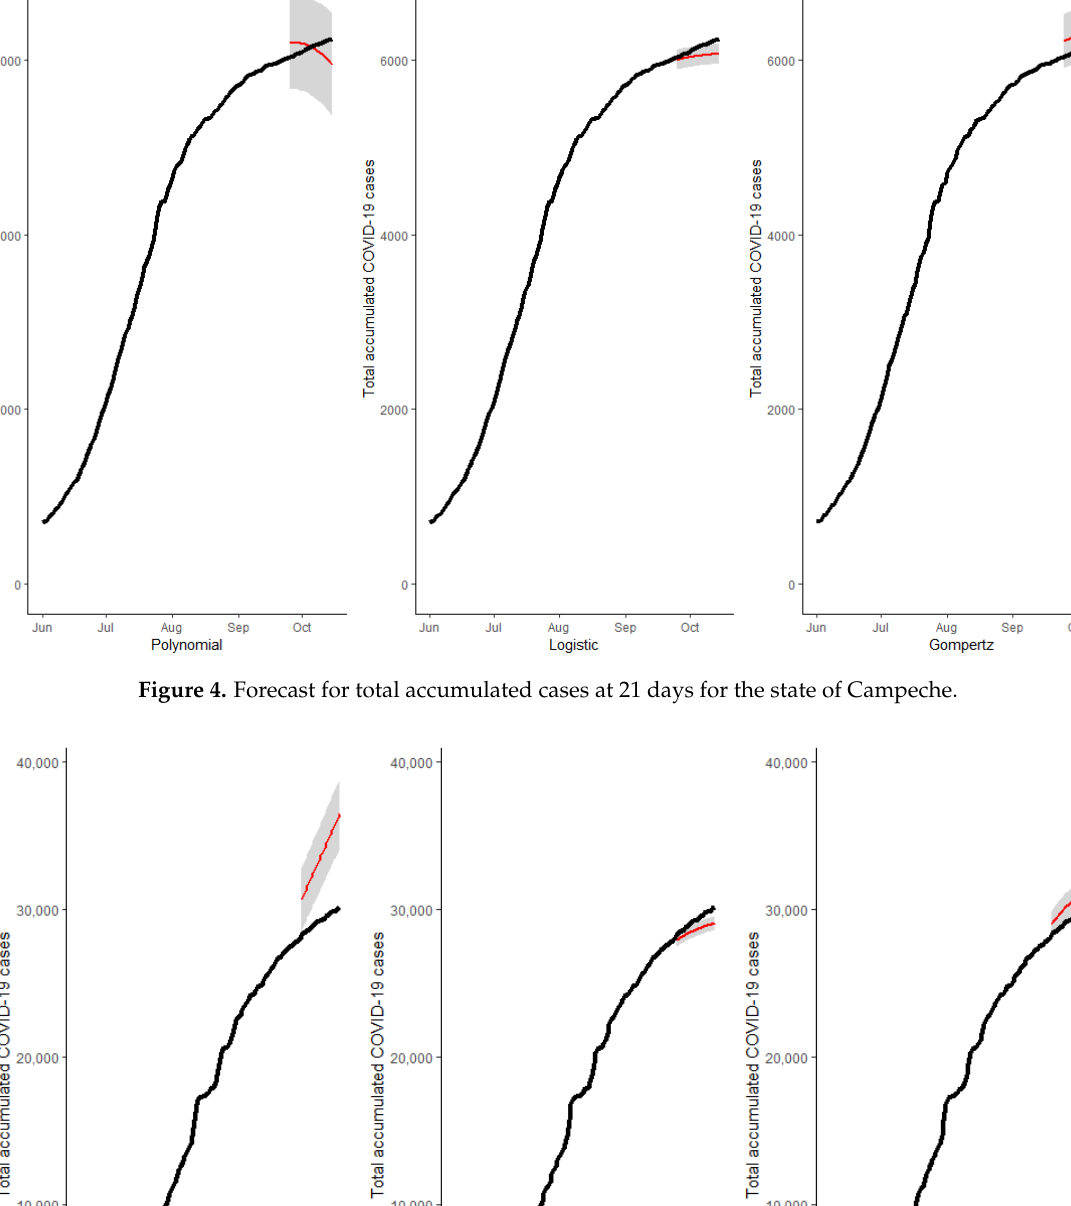
Figure 6. Forecast for total accumulated cases at 21 days for the state of Quintana Roo.